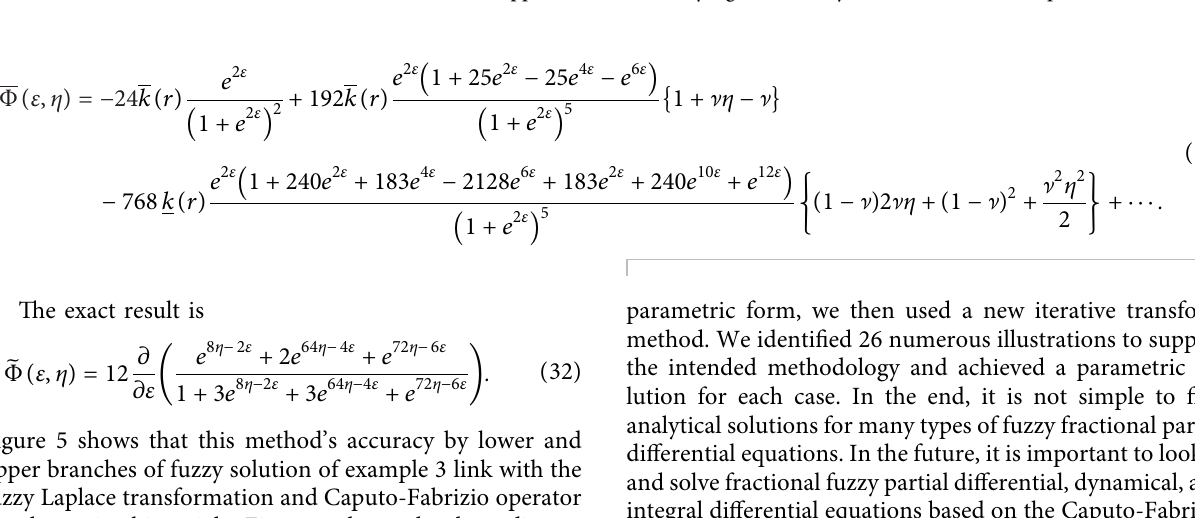
Figure 6: Various factional orders of the upper and lower fuzzy figure of analytical solution of example